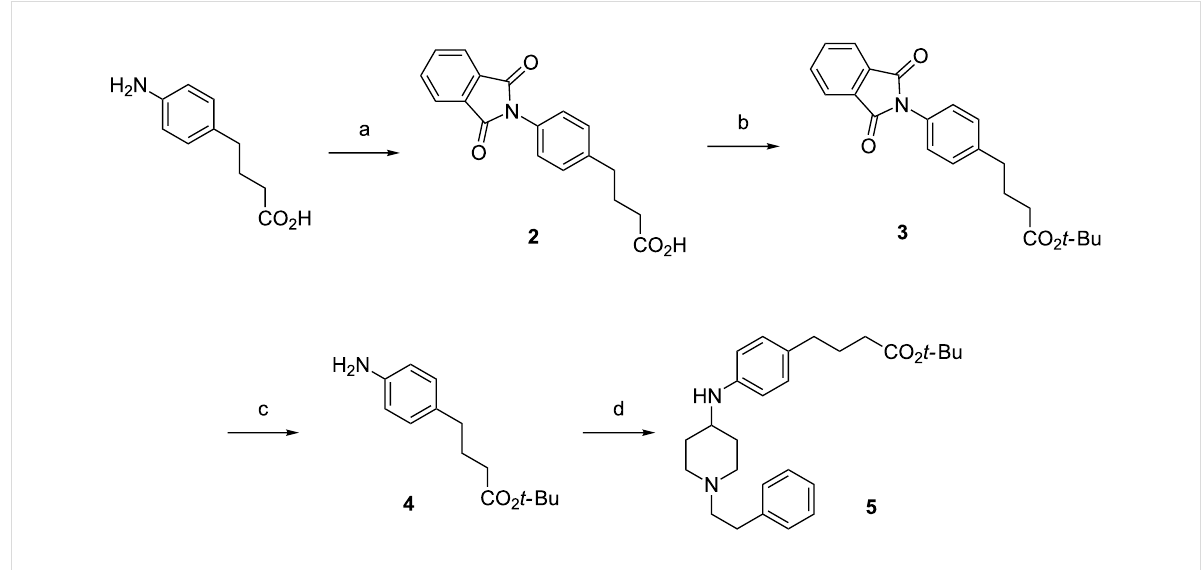
Scheme 2: Synthesis of fentanyl intermediate 5 . Reaction conditions: a) phthalic anhydride, AcOH, reflux, 81%; b) t -BuOH, EDC, Et 3 N, DMAP, CH